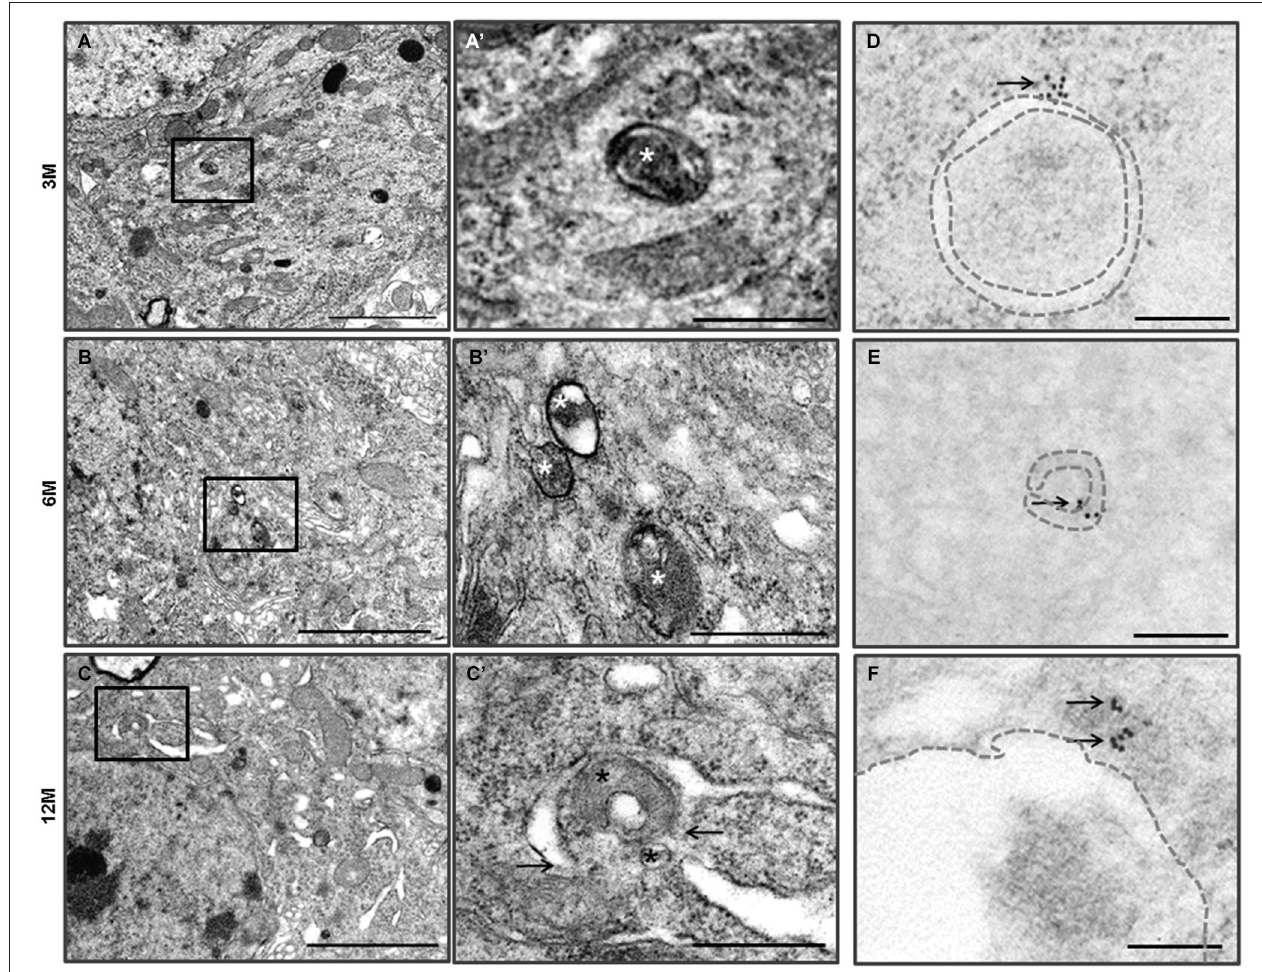
compared to the solid line boxes in (A–C) . (D–F) LC3B immunogold particles (arrows) were localized on the membrane (dotted lines) and lumens of vacuoles in the degenerated hippocampal neurons, which were undergoing autophagy. Scale bars, 2 µ m for (A–C) ; 500 nm for (A’–C’) ; 200 nm for (D–F)